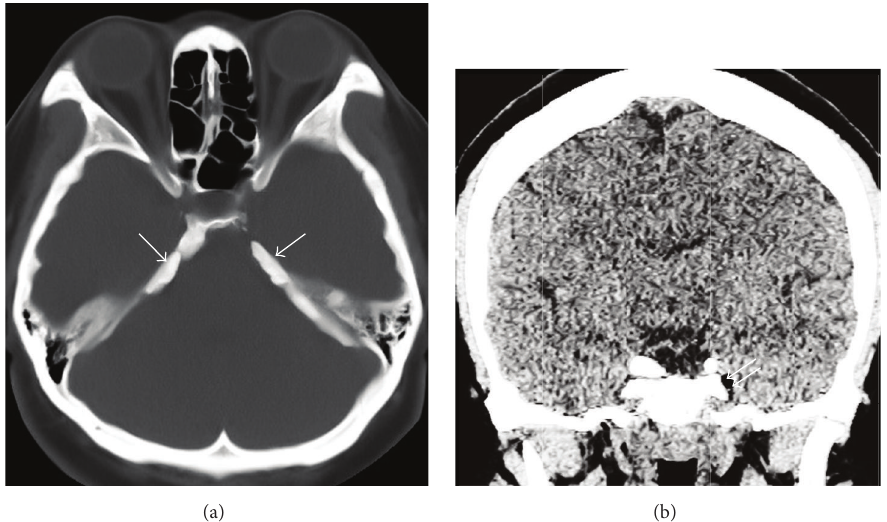
Figure 3: Brain CT image shows plaque-like tentorial ossification (arrow) on bone window (a) and an air bubble (double arrows) adjacent to left Meckel’s cave on brain window